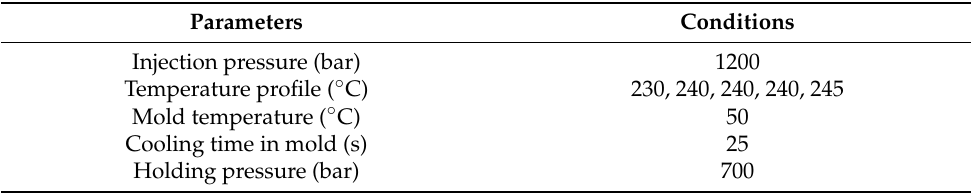
Table 3. Injection-molding